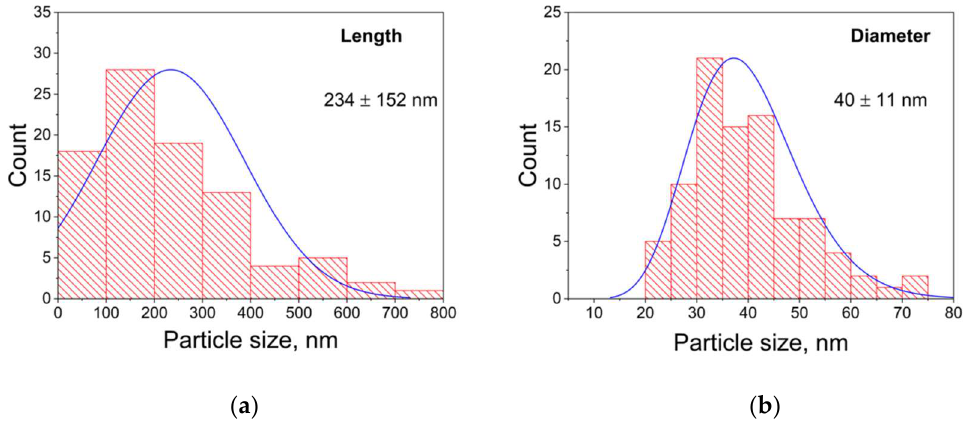
Figure 6. Distribution of length ( a ) and diameter ( b ) of obtained ANPs by size.